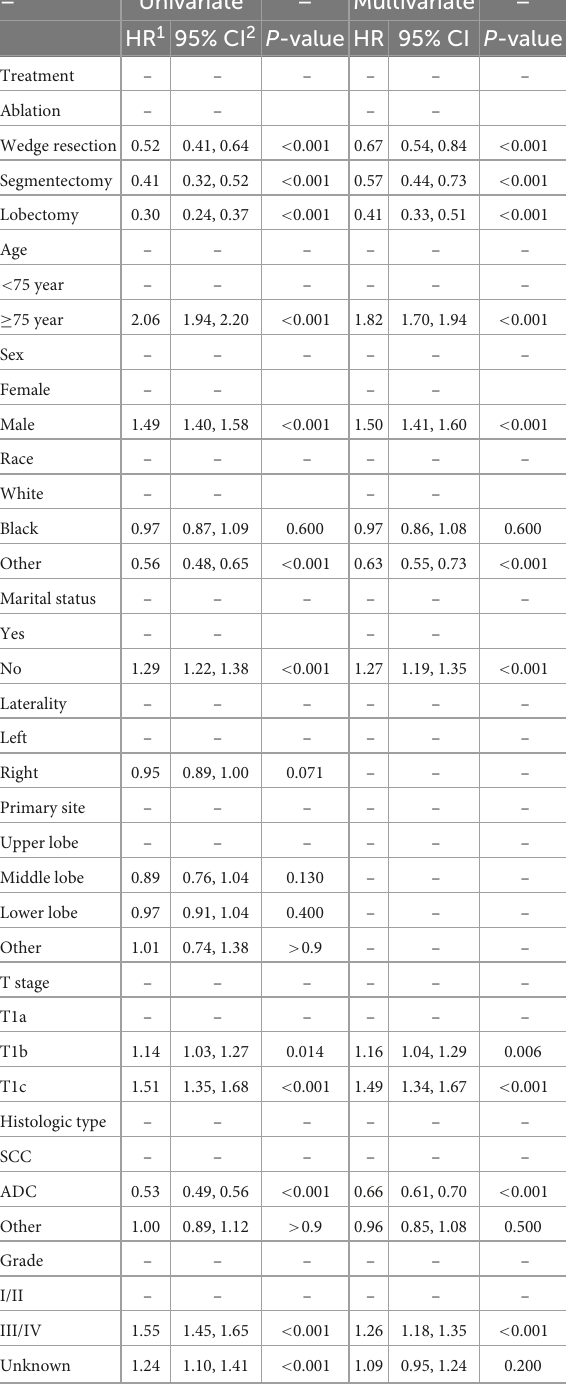
TABLE 2 Characteristics of stage IA NSCLC patients from SEER database.